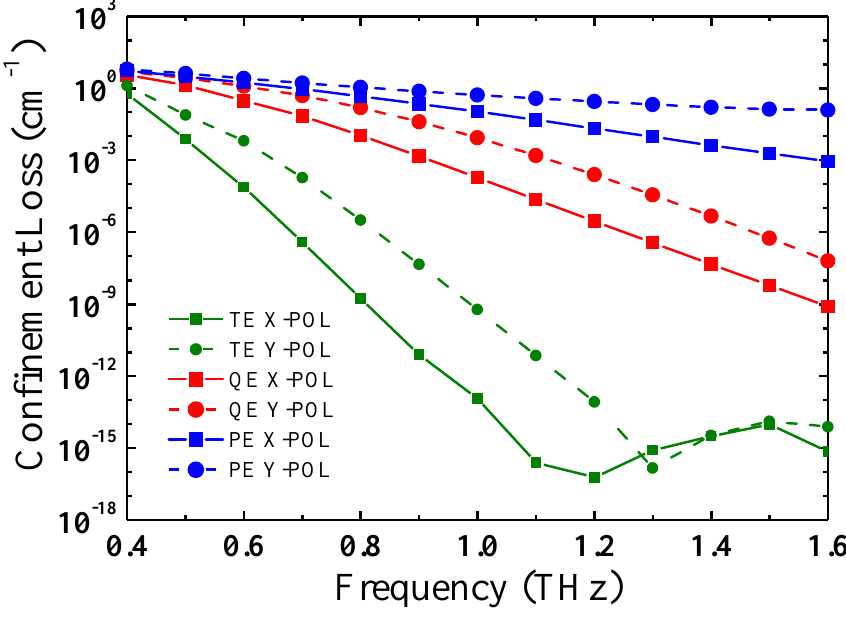
Figure 5. Response of confinement loss to frequency for the TE, QE, and PE designs.